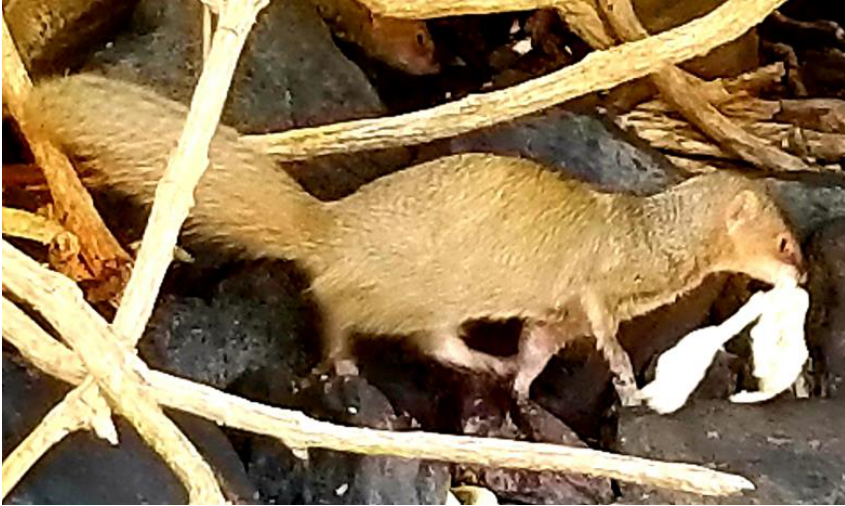
Figure 1. The small Indian mongoose ( Urva auropunctata ) on the Caribbean island of St.